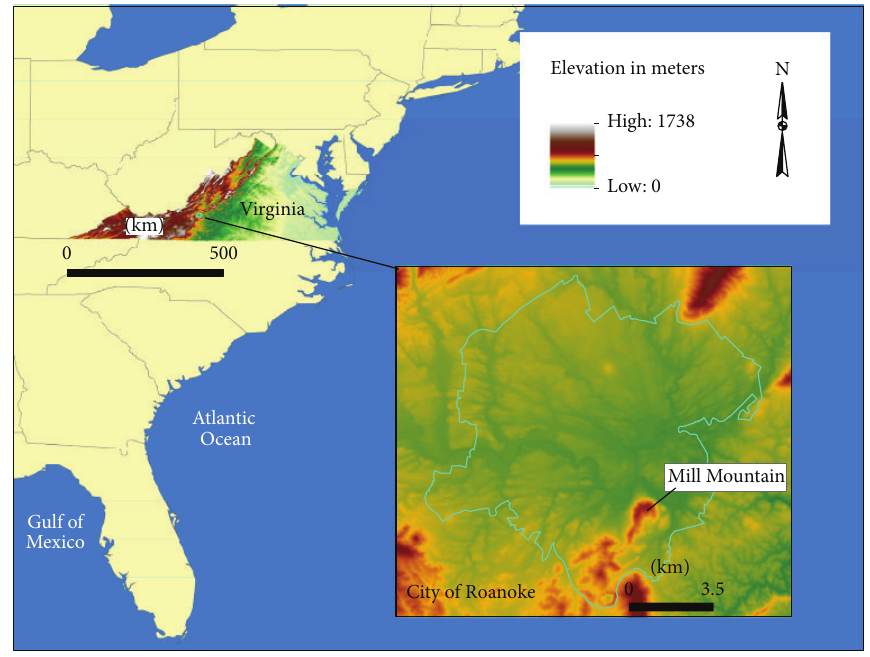
Figure 1: City of Roanoke, Virginia, reference map.